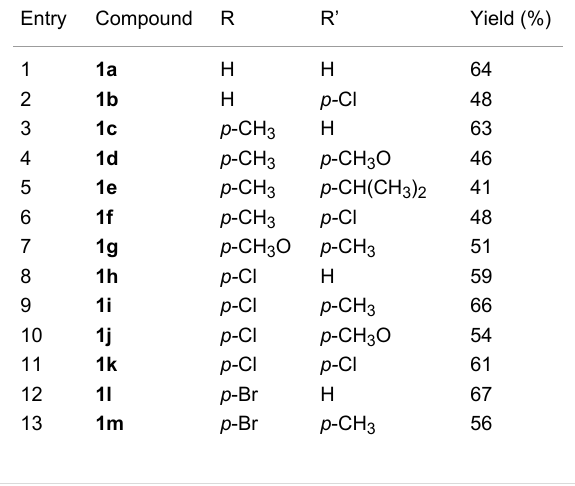
Table 1: Synthesis of the polysubstituted tetrahydroquinolines 1a – 1m .